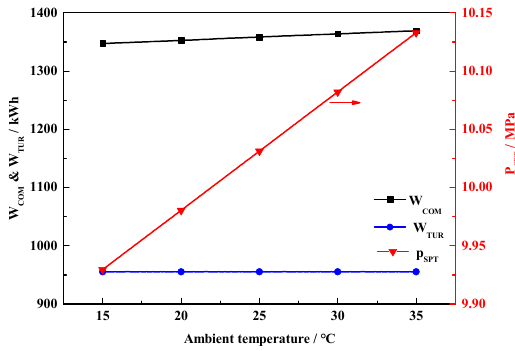
Figure 5. Effect of ambient temperature on W COM , W TUR , and P SPT .